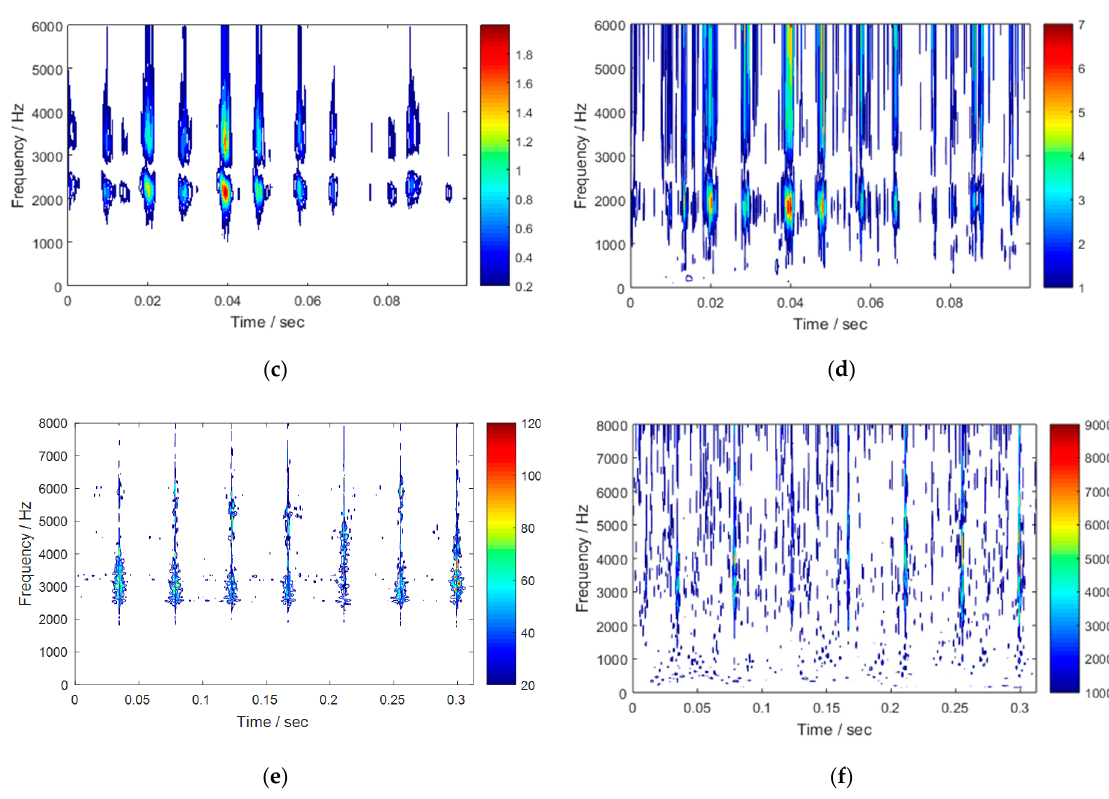
Figure 8. The comparison of the enhanced EWT and the conventional EWT: ( a ) Inner race fault—enhanced EWT; ( b ) Inner race fault—conventional EWT; ( c ) Outer race fault—enhanced EWT; ( d ) Outer race fault—conventional EWT; ( e ) Gear tooth fault—enhanced EWT; ( f ) Gear tooth fault—conventional EWT.